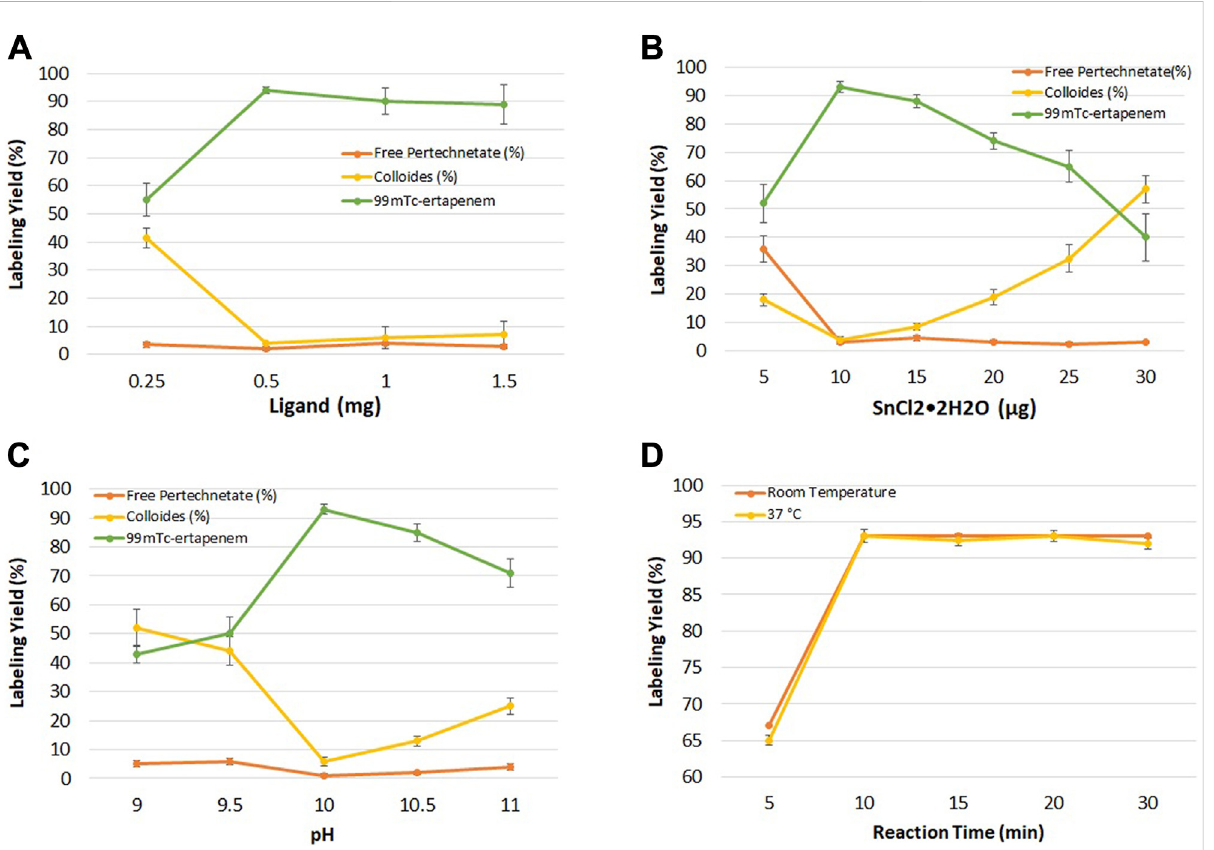
(cid:129) 2H 2 O)onradiochemicalyield; (C)